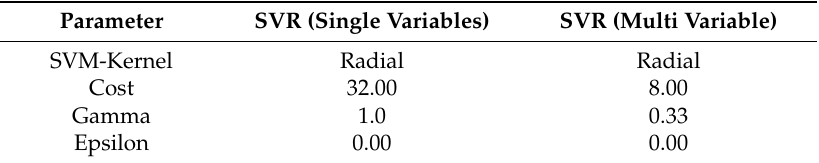
Table 2. SVR model parameter for forecasting wind power outputs on 8 January 2016.